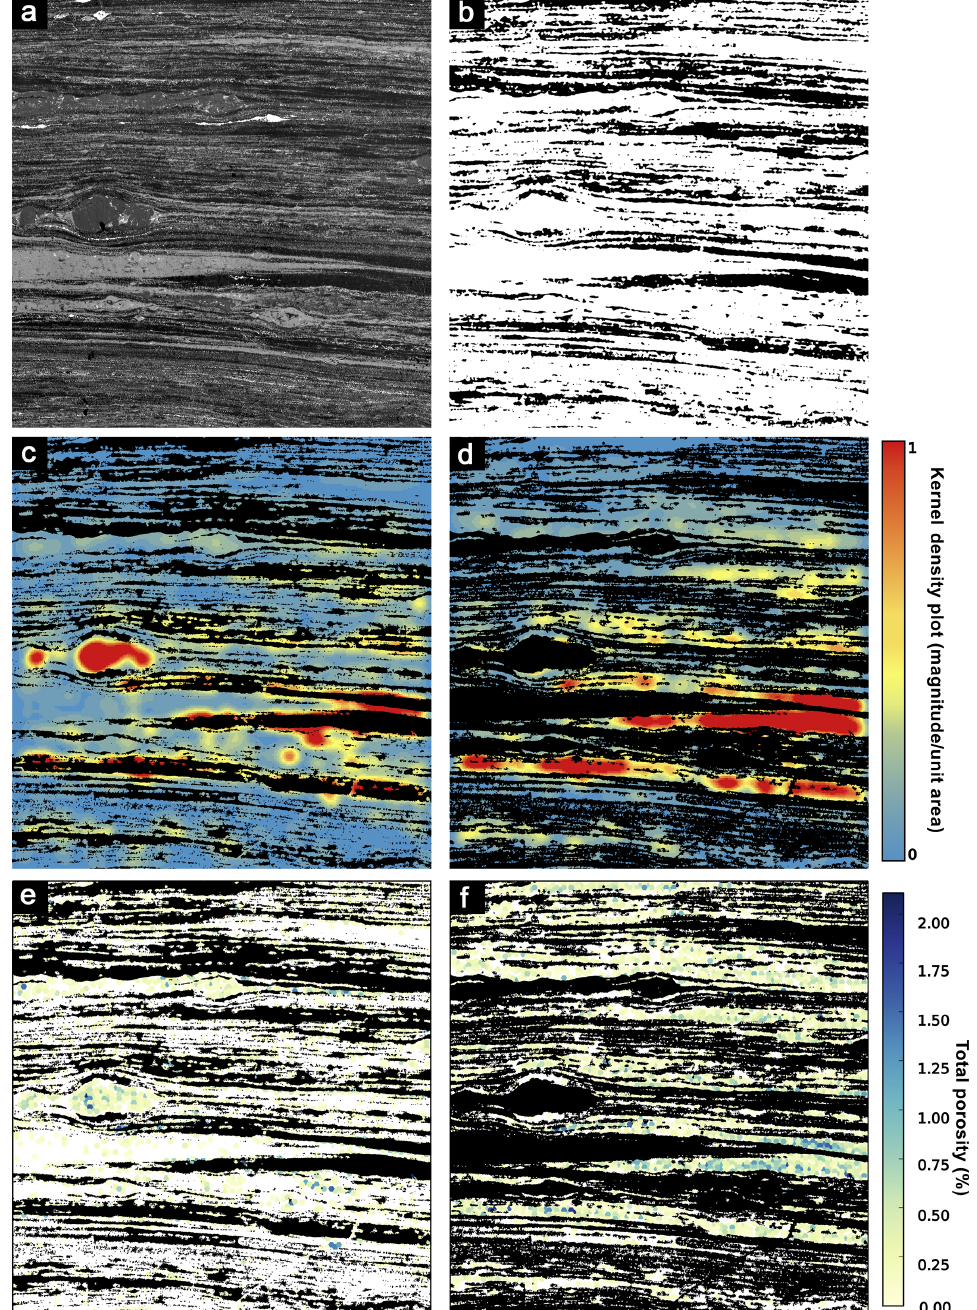
Figure 2. The spatial distribution of porosity in Fig. 1b. In the BSE mosaic of Fig. 1b, 8129 individual pores were identified. For reference, panel (a) displays the micro-fabric of the area analysed. Panel (b) is the mask used for distinguishing microstructural domains for analysis: quartz is coloured black. Panels (c, d) present masked kernel density analysis highlighting regions of pore clustering. Panel (c) is masked to remove all quartz and panel (d) is masked to only show the quartz. The clustering of pores is most prevalent in the thickest, most coherent quartz domains and in the largest feldspar porphyroclasts. Panels (e, f) are hexbin plots that are coloured to show the absolute porosity per hexbin, masked in the same fashion as panels (c, d) . See Table 1 for porosity values per domain.